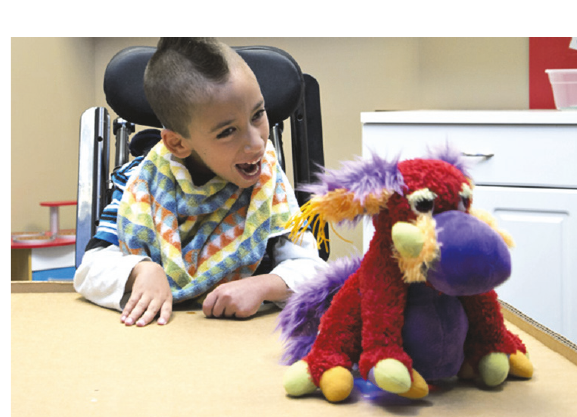
Figure 4: A sample interaction with the fully fabricated robotic toy. The child in the photo is representative of the study’s target population (with